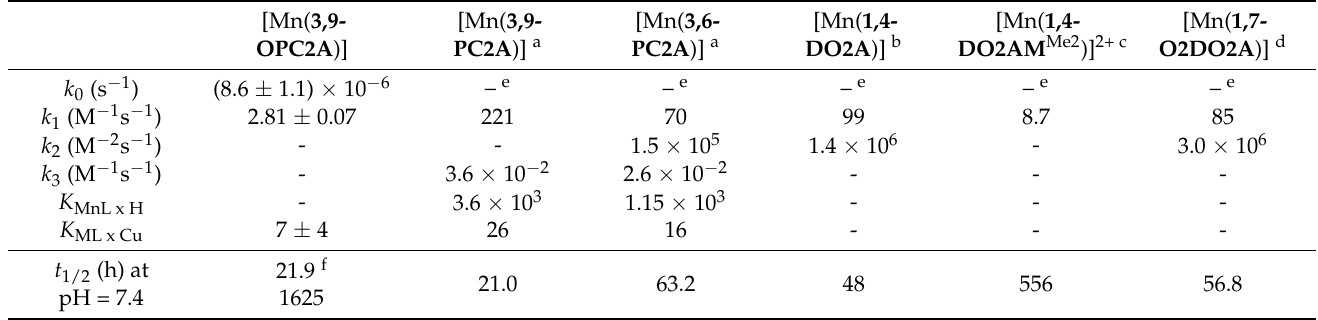
Table 6. Rate and equilibrium constants and half-lives at 7.4, for the dissociation reactions of [Mn( 3,9-OPC2A )], [Mn( 3,9-PC2A )], [Mn( 3,6-PC2A )], [Mn( 1,4-DO2A )], Mn( 1,4-DO2AM Me2 )] 2+ ,